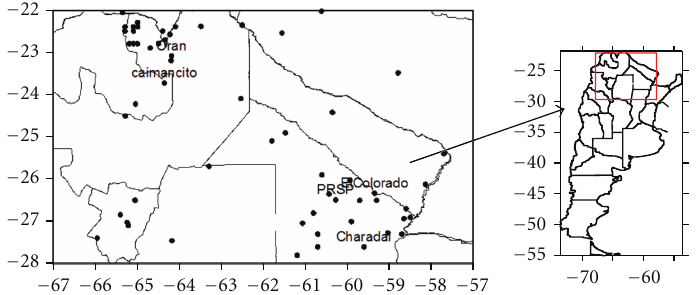
Figure 1: Stations used in the study. Stations refered to in Result section are detailed.